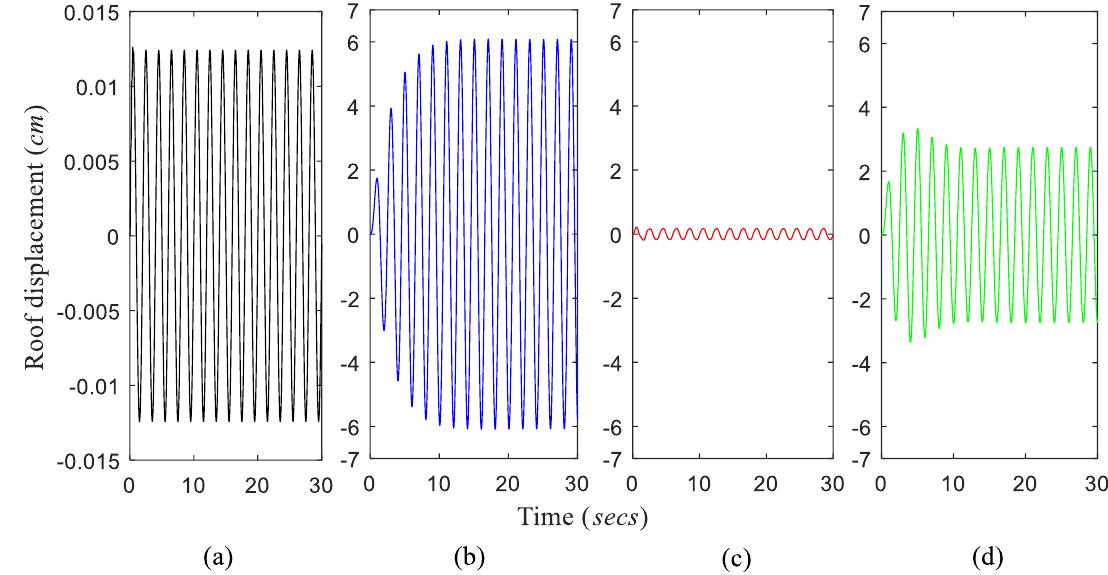
Fig. 11. Time history of roof displacement of (a) Fixed base (b) Isolated base with LRB (c) Isolated base with LPB (d) Isolated base with LRB and TMD structures under wind